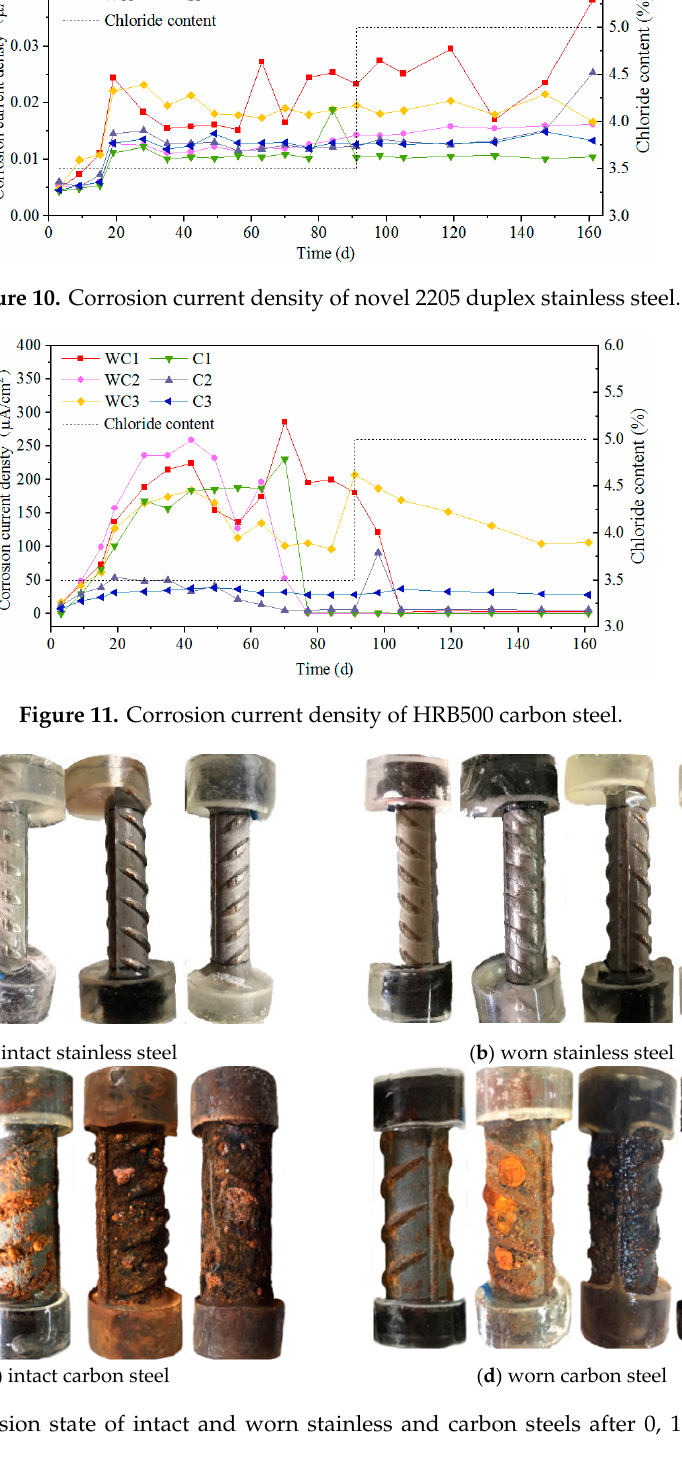
Figure 12. Corrosion state of intact and worn stainless and carbon steels after 0, 10, 90 and 160 days’ exposure.